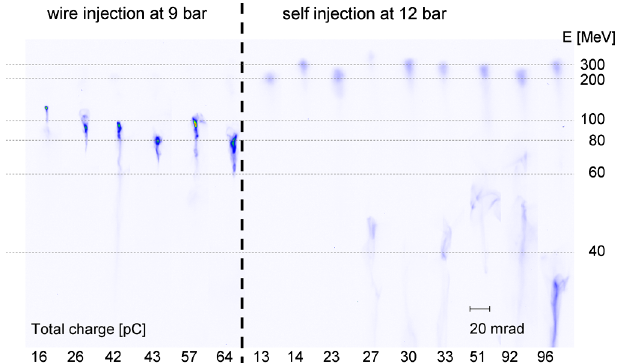
FIG. 5. Example spectra of beams with variable charge and fixed wire position; left: wire injection at 9 bar backing pressure; right: self-injection at 12 bar backing pressure to compensate for the charge increase in the wire injection case as indicated in Fig. 2. Each group has been sorted according to integrated charge and the spectra are displayed on an equal lateral and normalized color